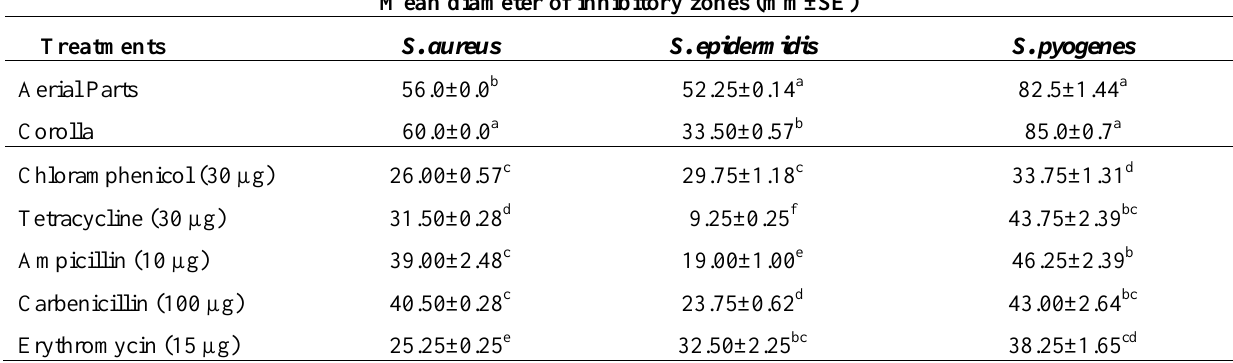
Table 2. Antibacterial activity against Gram-positive bacteria of the aerial parts and corolla essential oils from O. acutidens.